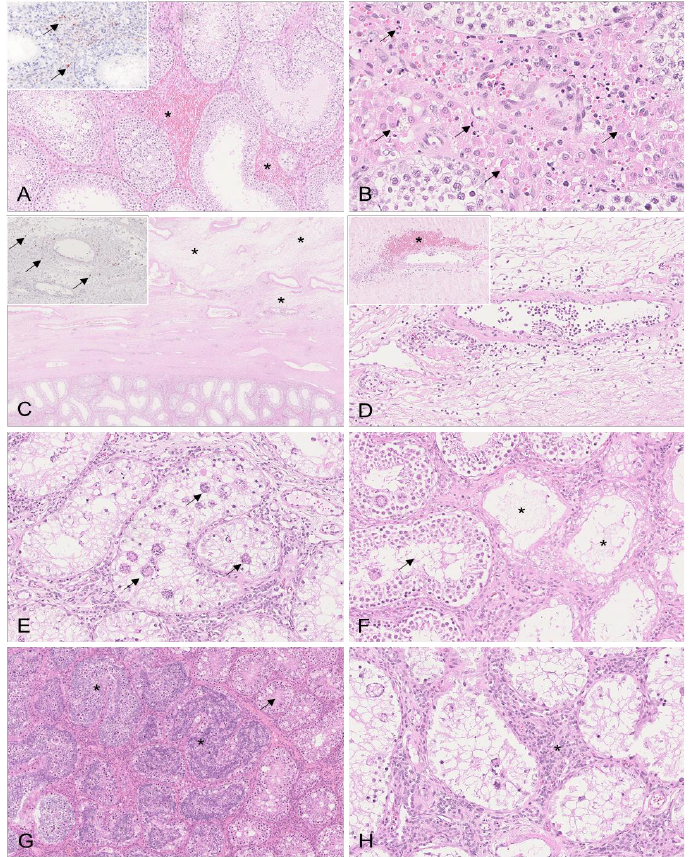
Figure 2. Histopathological changes to the testis in mature boars infected with moderately virulent ASFV “Estonia2014”. ( A ) HE, boar #1; hemorrhages in the testicular interstitium (asterisk). Inset: IHC, positively labeled cells (arrow) consistent with histiocytes located in the interstitium of the testis. ( B ) HE, boar #1; multifocal necrosis/apoptosis of Leydig cells (arrows). ( C ) HE, boar #1; diffuse edema expanding the tunica vasculosa and albuginea (asterisk). Inset: IHC, numerous positively labeled cells (arrow) morphologically consistent with macrophages are present in the tunica vascu- losa and albuginea. ( D ) HE, boar #1; blood vessel of the tunica vasculosa with activated endothelium and transmural and perivascular infiltrates. Inset: blood vessel of the tunica albuginea with fibrinoid necrosis of the vessel wall, intramural infiltrates, and perivascular infiltrates and hemorrhage (as- terisk). ( E ) HE, boar #3; seminiferous tubule with severe germ cell degeneration, epithelial vacuola- tion, and the formation of multinucleated giant cells (arrows). ( F ) HE, boar #4; seminiferous tubules showing different stages of degeneration with completely atrophied tubules (asterisk) adjacent to degenerating tubules with formation of single giant cells (arrow). ( G ) HE, boar #3; mildly dilated seminiferous tubules with accumulating spermatozoa and degenerating germ cells with giant cell formation (asterisk) adjacent to tubules with beginning vacuolation of germ cell epithelium (arrow). ( H ) HE, boar #3; proliferation of Leydig cells (asterisk) between degenerating seminiferous tubules.